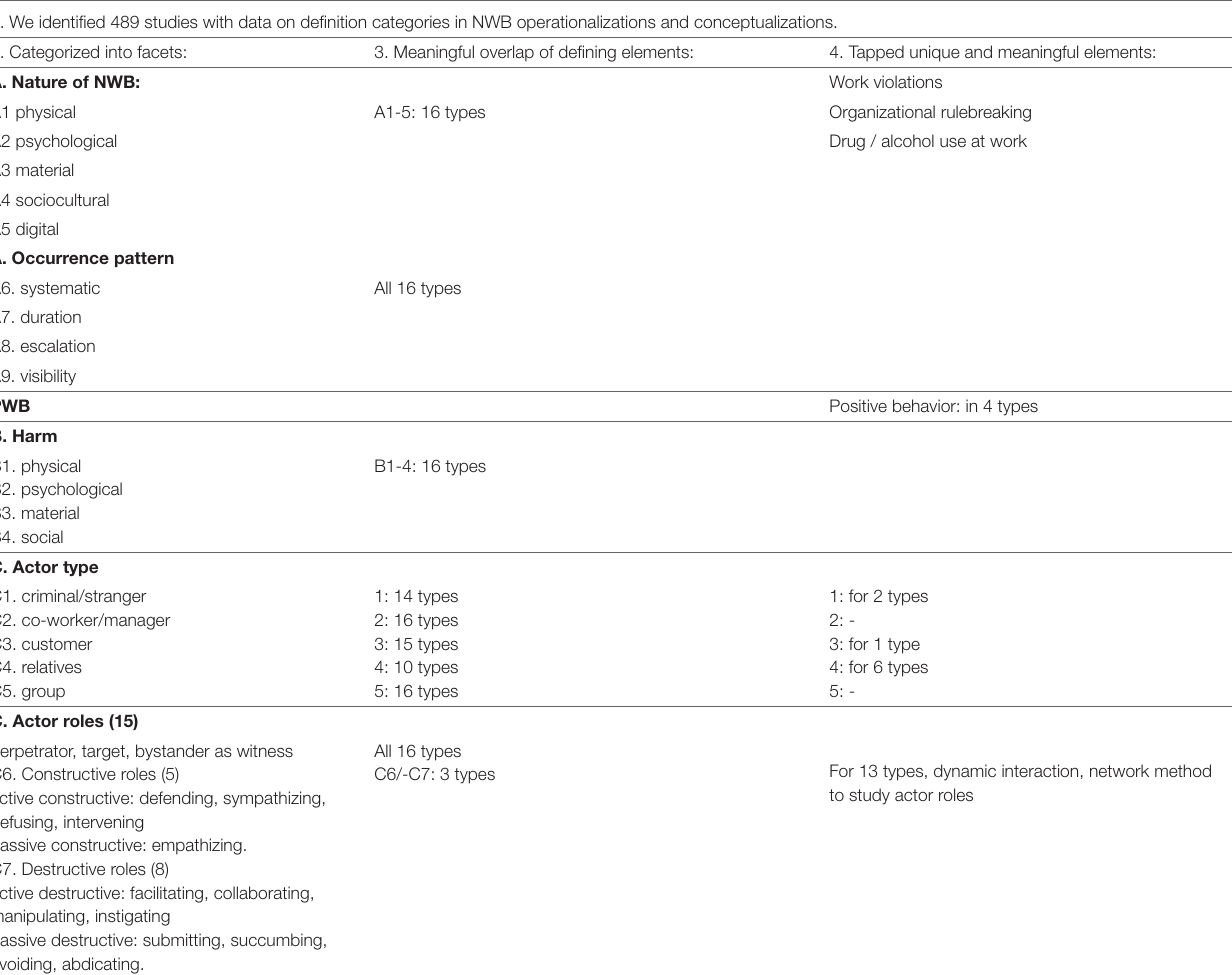
TABLE 3 | Facets, categories, overlap and unique elements in NWB operationalizations and